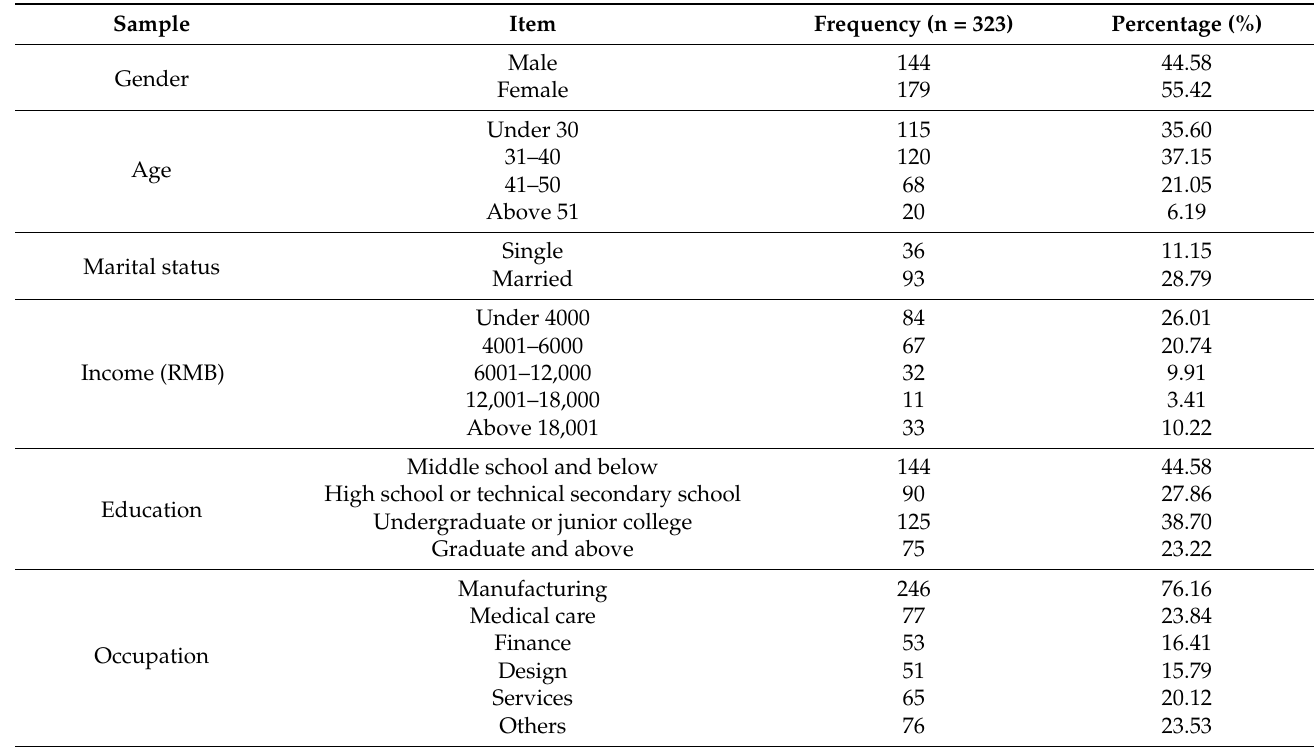
Table 2. Table for sample basic